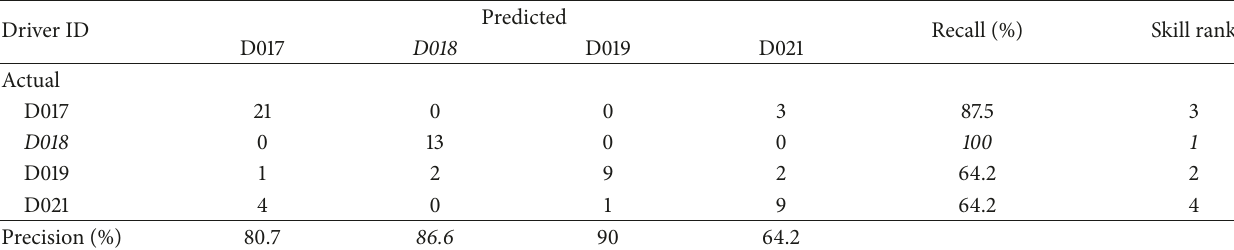
Table 9: Confusion matrix on group 3 (G3) of drivers.